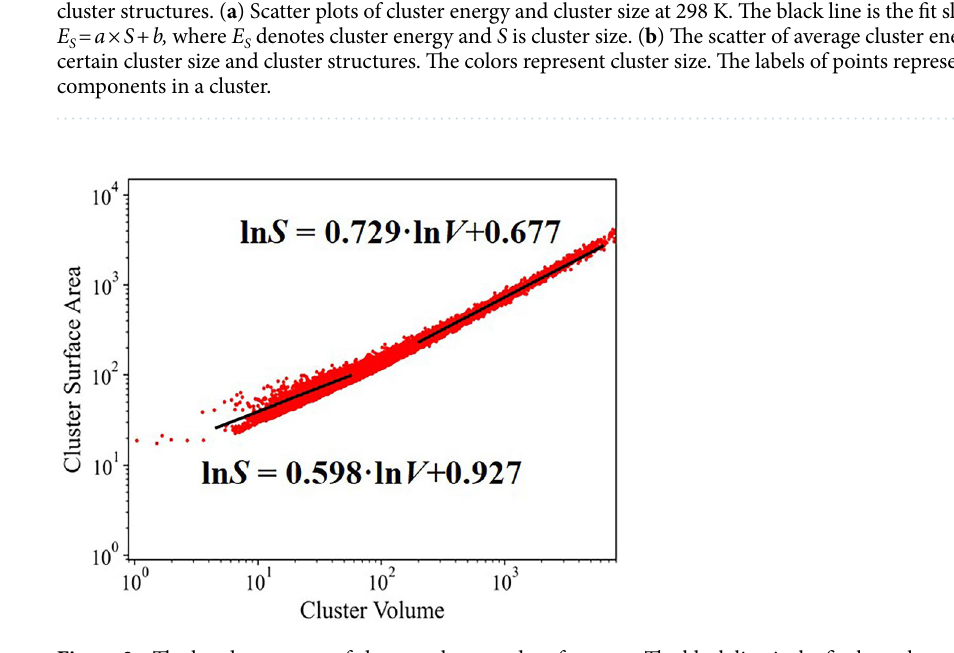
Figure 3. The log–log scatters of cluster volume and surface area. The black line is the fit slopes by lnS ~ alnV +